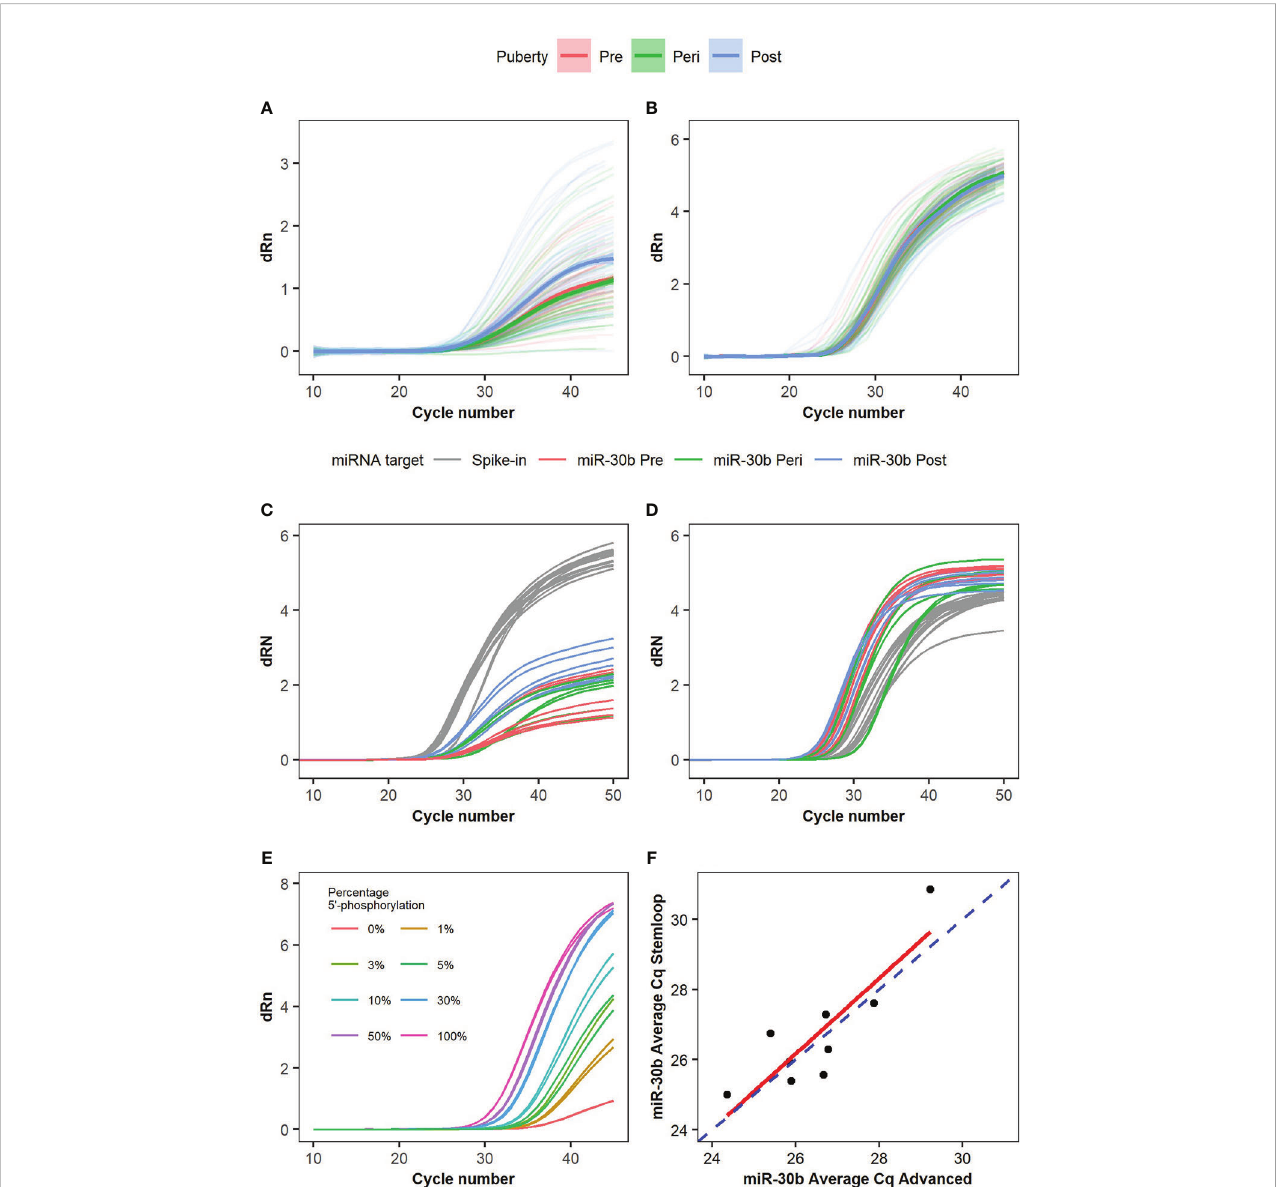
FIGURE 3 Ambiguous ampli fi cation curves and phosphorylation level of miR-30b. Ampli fi cation curves for (A) miR-30b and (B) spike-in control miR159a were analyzed in samples from the main cohort using the Advanced setup. n=39 boys with 3 samples each. Trendlines with con fi dence intervals indicating the average ampli fi cation curve for pre- (red), peri- (green), and post-pubertal (blue) samples are shown, and the individual curves are seen in the background with faded, matched colors according to the pubertal stage. Nine samples were measured with both (C) the Advanced miRNA setup and (D) the stem-loop miRNA setup and the ampli fi cation curves are colored according to target (grey for spike-in independent of the pubertal state, red for miR-30b in pre-pubertal samples, green for miR-30b in peri-pubertal samples, and blue for miR-30b in post-pubertal samples). (E) Ampli fi cation curves for synthetic miR-30b with and without 5 ’ -phosphorylation measured by RT-qPCR using the Advanced miRNA setup. Different percentages of miR-30b with 5 ’ -phosphorylation were mixed with miR-30b without 5 ’ -phosphorylation to investigate the change in the shape of the curves depending on the percentage of fully functional and 5 ’ -phosphorylated miRNAs in the sample. The maximum dRn value is visibly lower when only 10% of the miRNAs are 5 ’ -phosphorylated but a rising curve is still observed when only non-phosphorylated (inactive) miRNAs are present although no exponential phase is seen. (F) Correlation plot comparing the miR-30b Cq values of the nine samples using the advanced miRNA setup vs. the stem-loop miRNA setup. The dashed blue line represents x=y, the red line represents the linear model for the correlation of the two setups. Individual dots represent the nine samples analyzed. Correlation coef fi cient: 0.86, Adjusted R 2 : 0.7033, p-value: